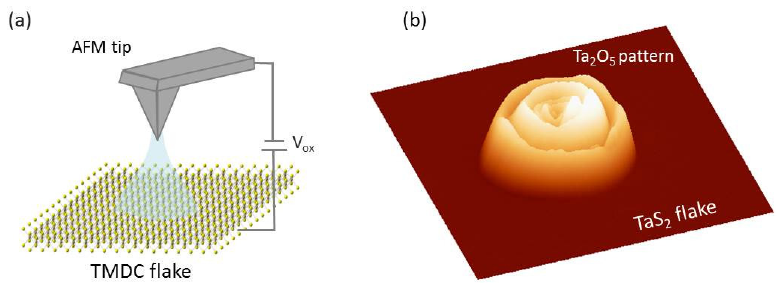
Figure 1. ( a ) Schematic representation of the LON set; ( b ) Dynamic-tip AFM-LON performed on the surface of TaS 2 flakes. AFM 3D topography image of a rippled mound performed on a thick layer of TaS 2 . Image size: 5 μ m × 5 μ m.